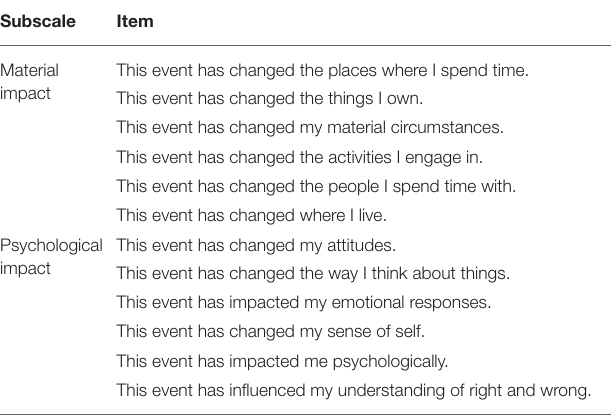
TABLE 1 | Transitional impact scale (TIS-12, Svob et al., 2014). Subscale Item Material